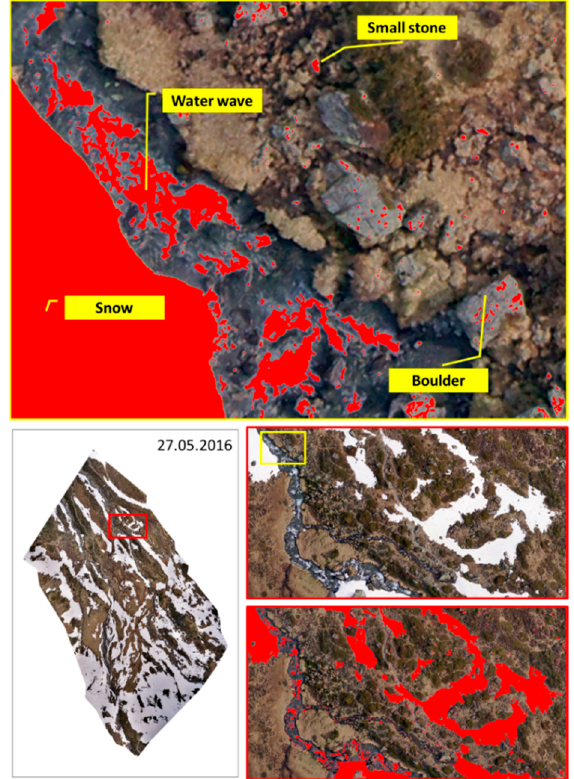
Figure 7. Incorrectly classified pixels in UAS orthophotos (red represents snow cover).